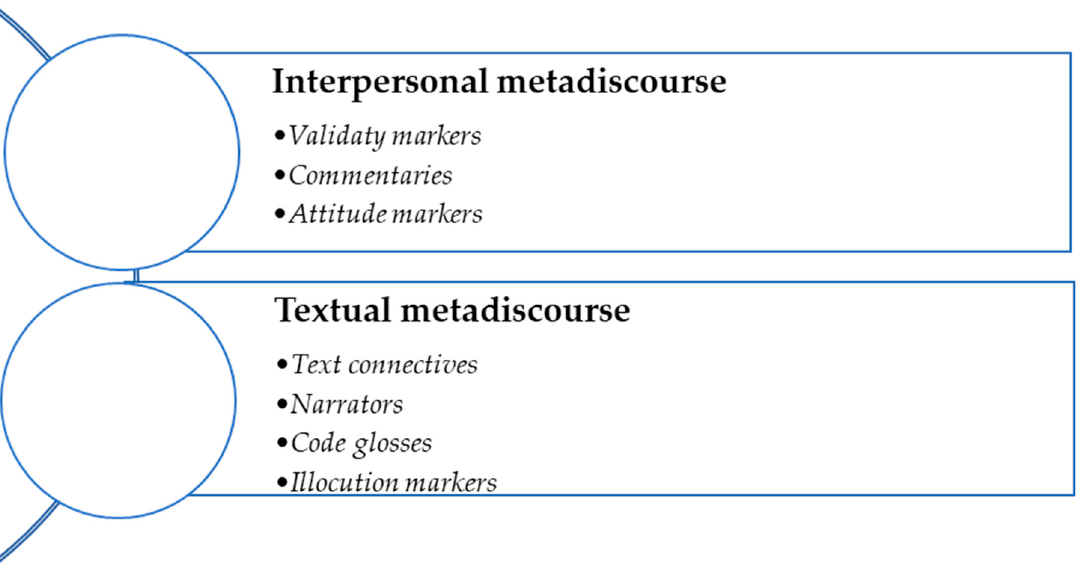
Figure 2. Vande Kopple’s (1985) model [9].